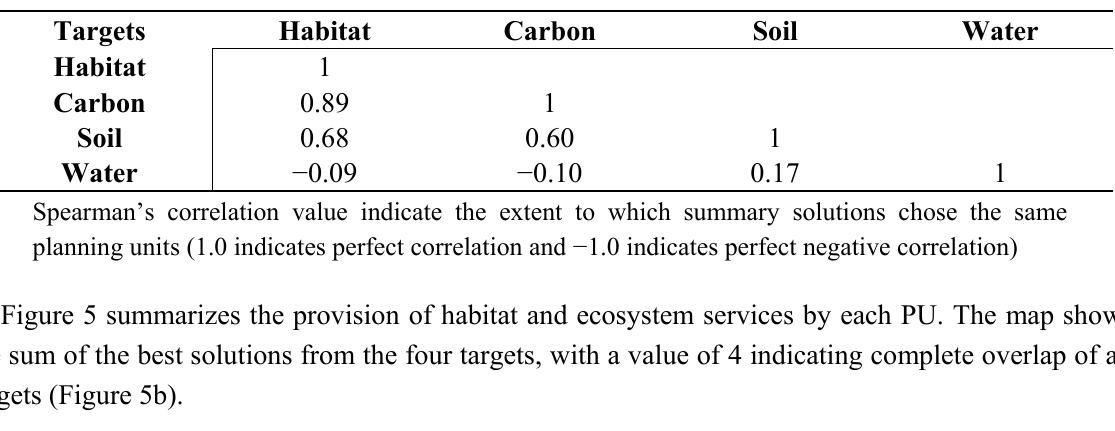
Table 2. Spearman’s ranked correlations of irreplaceable (summed solution) planning units among the conservation targets (ecosystem services and